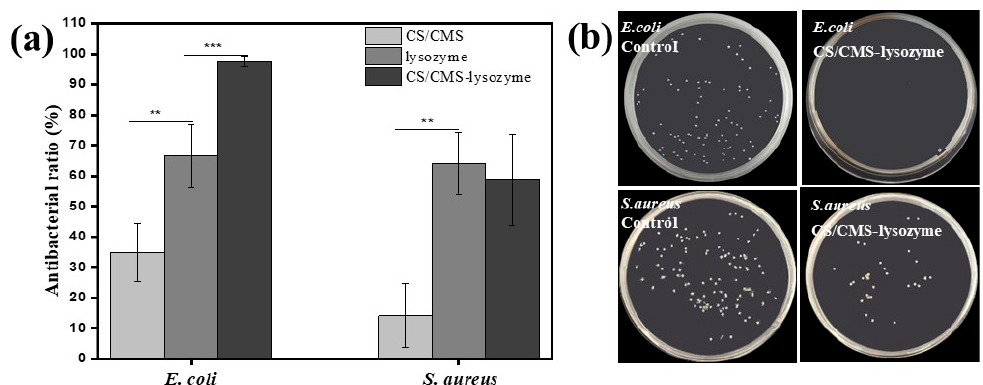
Figure 7. In vitro antibacterial activity: ( a ) antibacterial ratio against E. coli and S. aureus , ( b ) re-cultivated bacterial colonies on agar after bacteria dissociation from antibacterial tests. The data of antibacterial ratio were analyzed using a two-tailed unpaired Student’s t -test. The error bars indicate means ± SD. **: p < 0.01 and ***: p < 0.001.